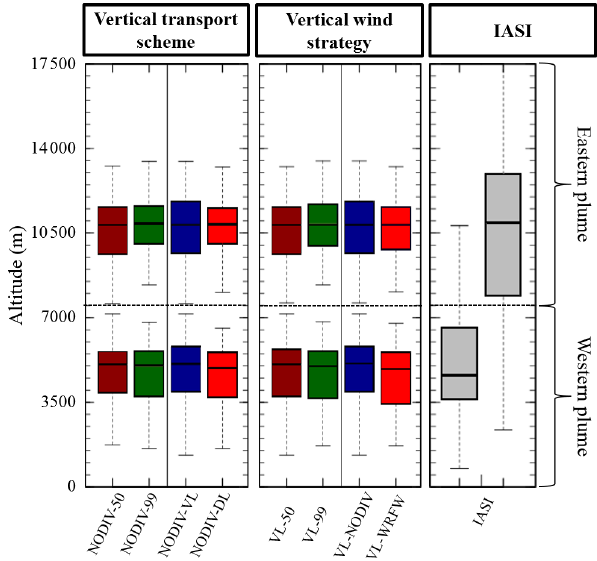
Figure 6. The SO 2 plume maximum concentration’s altitude distri- butions for IASI measurements and CHIMERE model simulations for the different configurations tested. The extents of the whiskers correspond to the distribution’s 10th and 90th